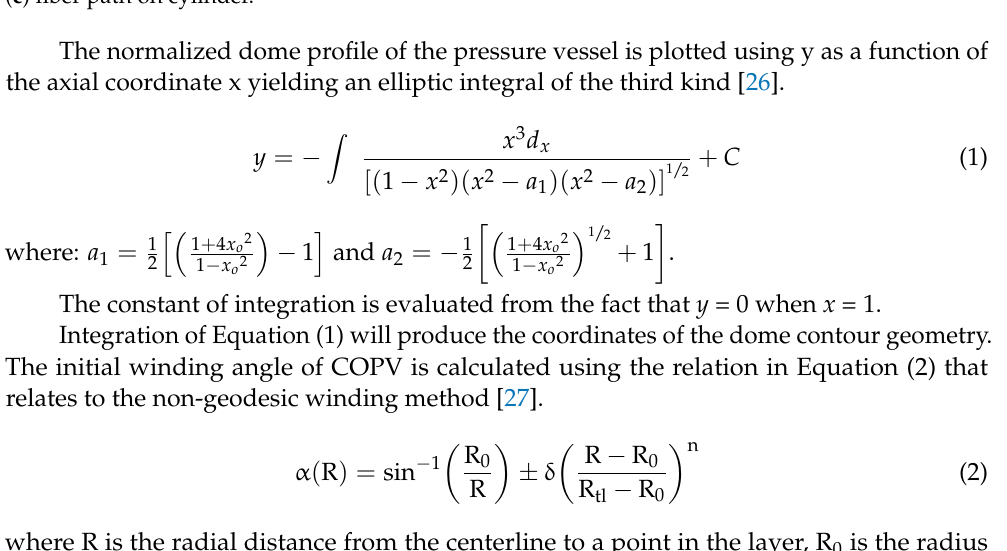
Figure 2. COPV: ( a ) fiber geodesic path on dome, ( b ) schematic view of vessel coordinates, and ( c ) fiber path on cylinder. ( c ) fiber path on